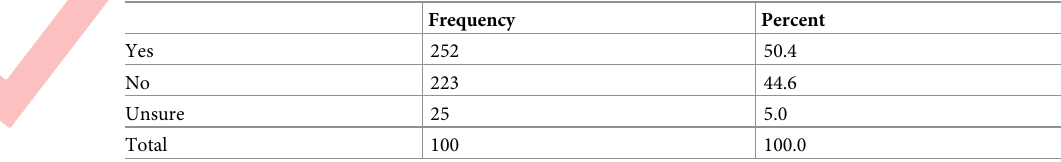
Table 3. Do you know anyone who have malaria fever